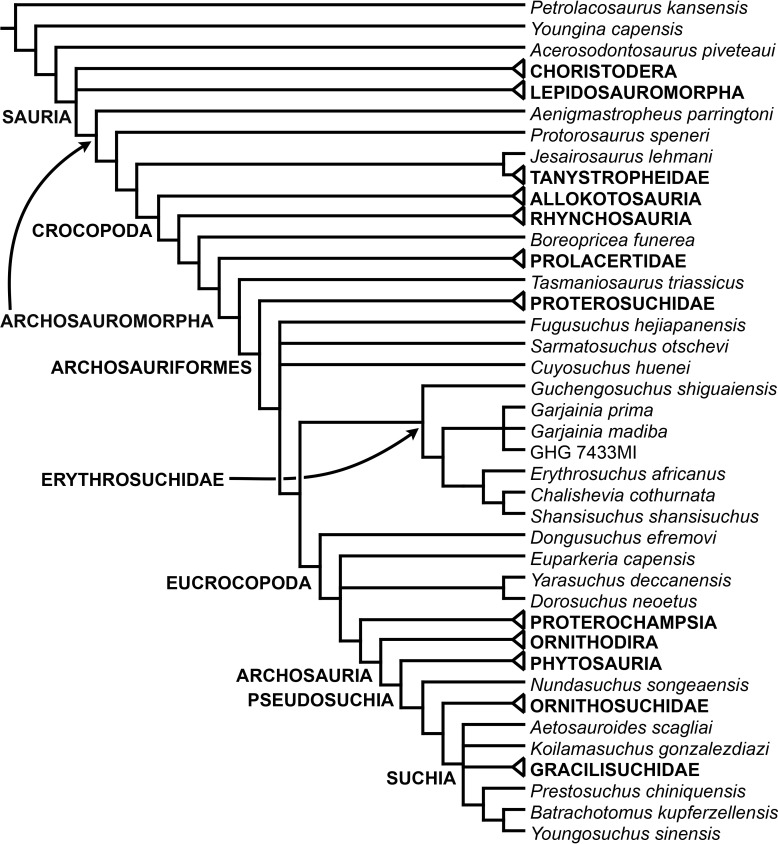
Fourth strict reduced consensus tree recovered from analyses 1 and 2.Some clades have been condensed into suprageneric terminals to simplify the figure and their internal relationships are the same as in previous figures.